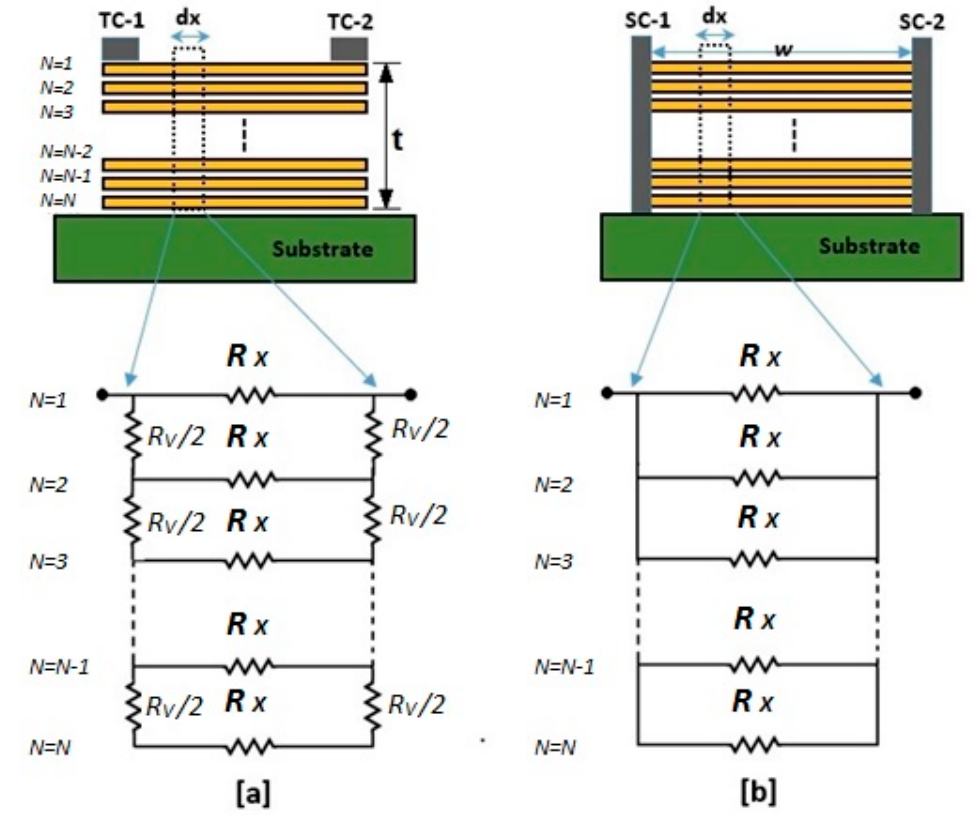
Figure 10. Schematic of multilayer graphene nanoribbon (MLGNR) interconnects with equivalent resistive network for ( a ) Top contact (TC) technology and ( b ) side contact (SC) technology.